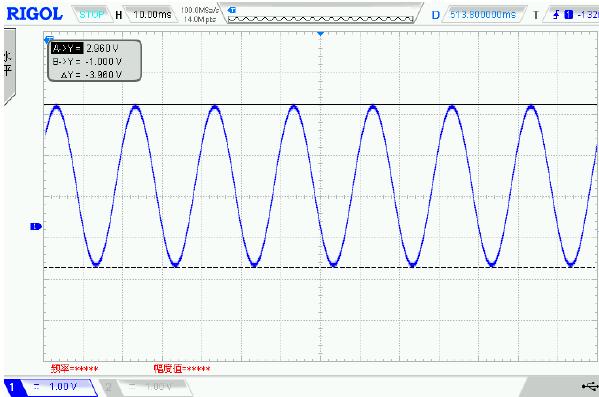
Figure 12. Experimental test results of the zero-sequence signal monitoring circuit.